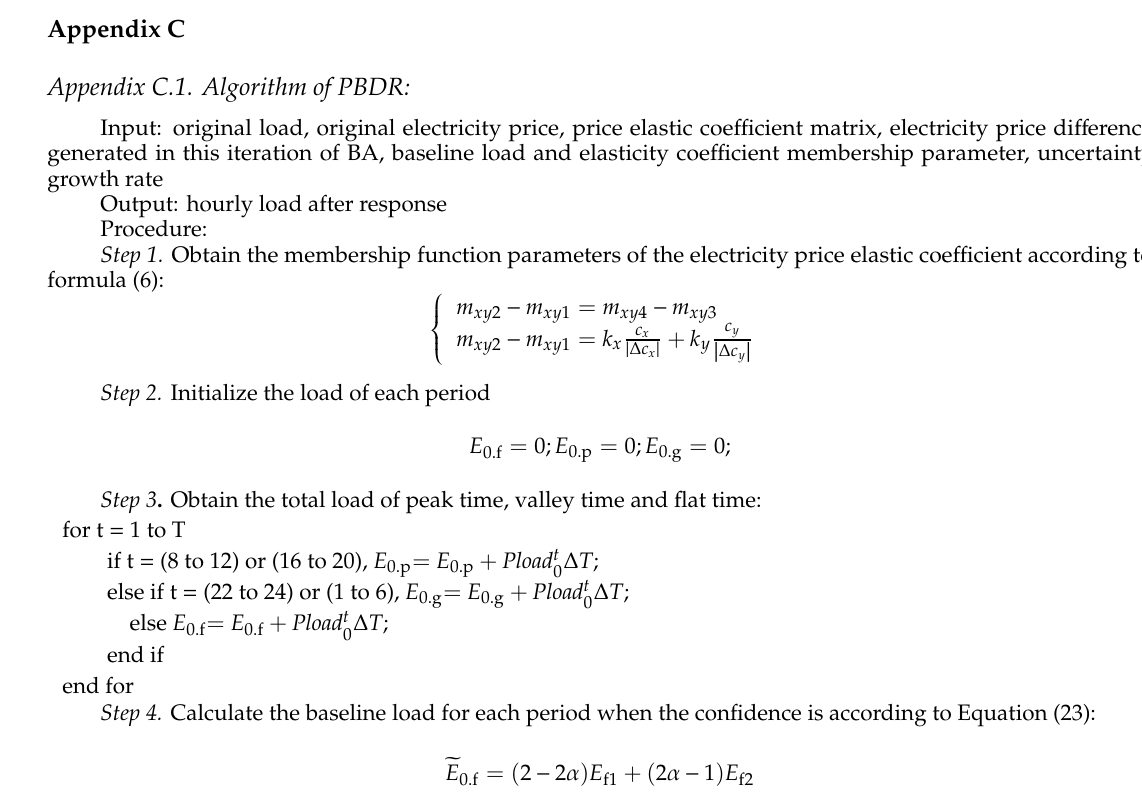
Figure B1. Elastic coefficient membership function. Figure A1. Elastic coe ffi cient membership function.